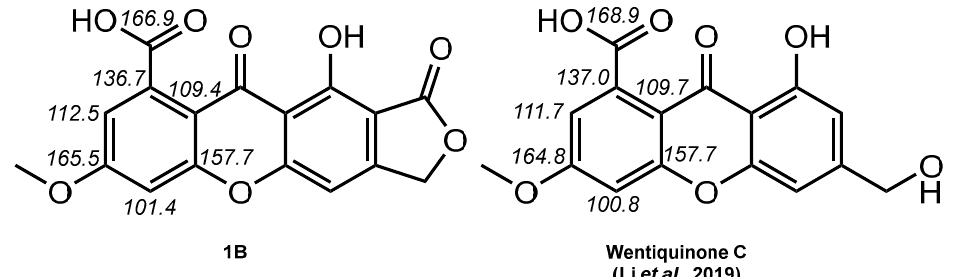
Figure 3. Compared 13 C NMR chemical shifts related to C-ring signals of 1B with those of wentiqui- none C (the chemical shifts used for comparison are taken from the NMR spectra acquired in DMSO- d 6 ).